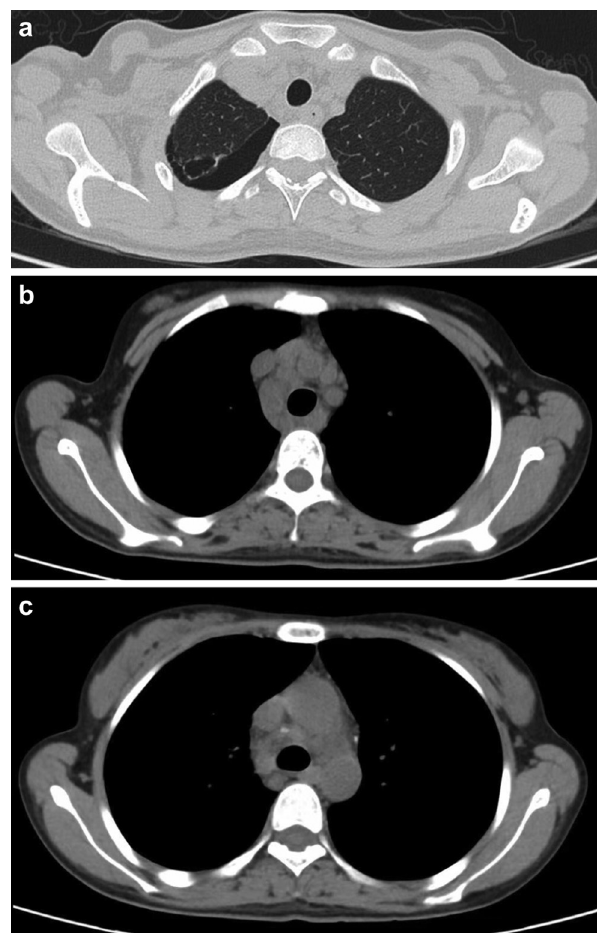
Figure 2: Chest computerized tomography images showing ( a ) right pneumothorax, ( b ) lymphadenectasis in the left axilla, and ( c ) lymphadenectasis in the